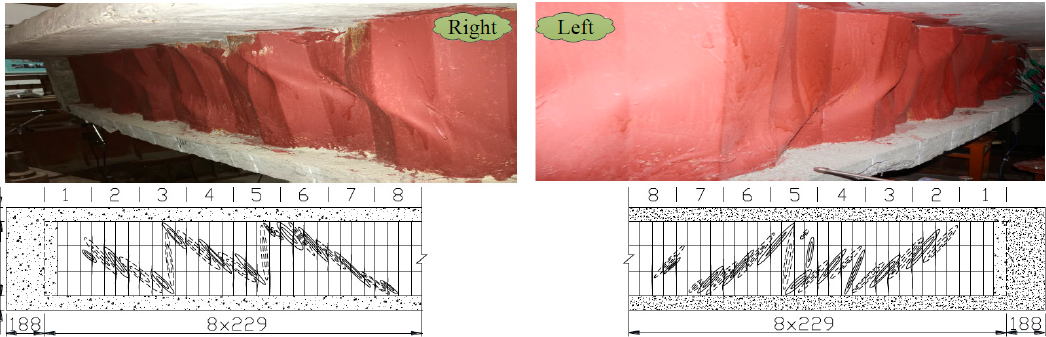
Figure 14. The final buckling shapes of CSWs for specimen S1-t1d2: ( a ) Outer CSW; ( b ) Inner CSW.